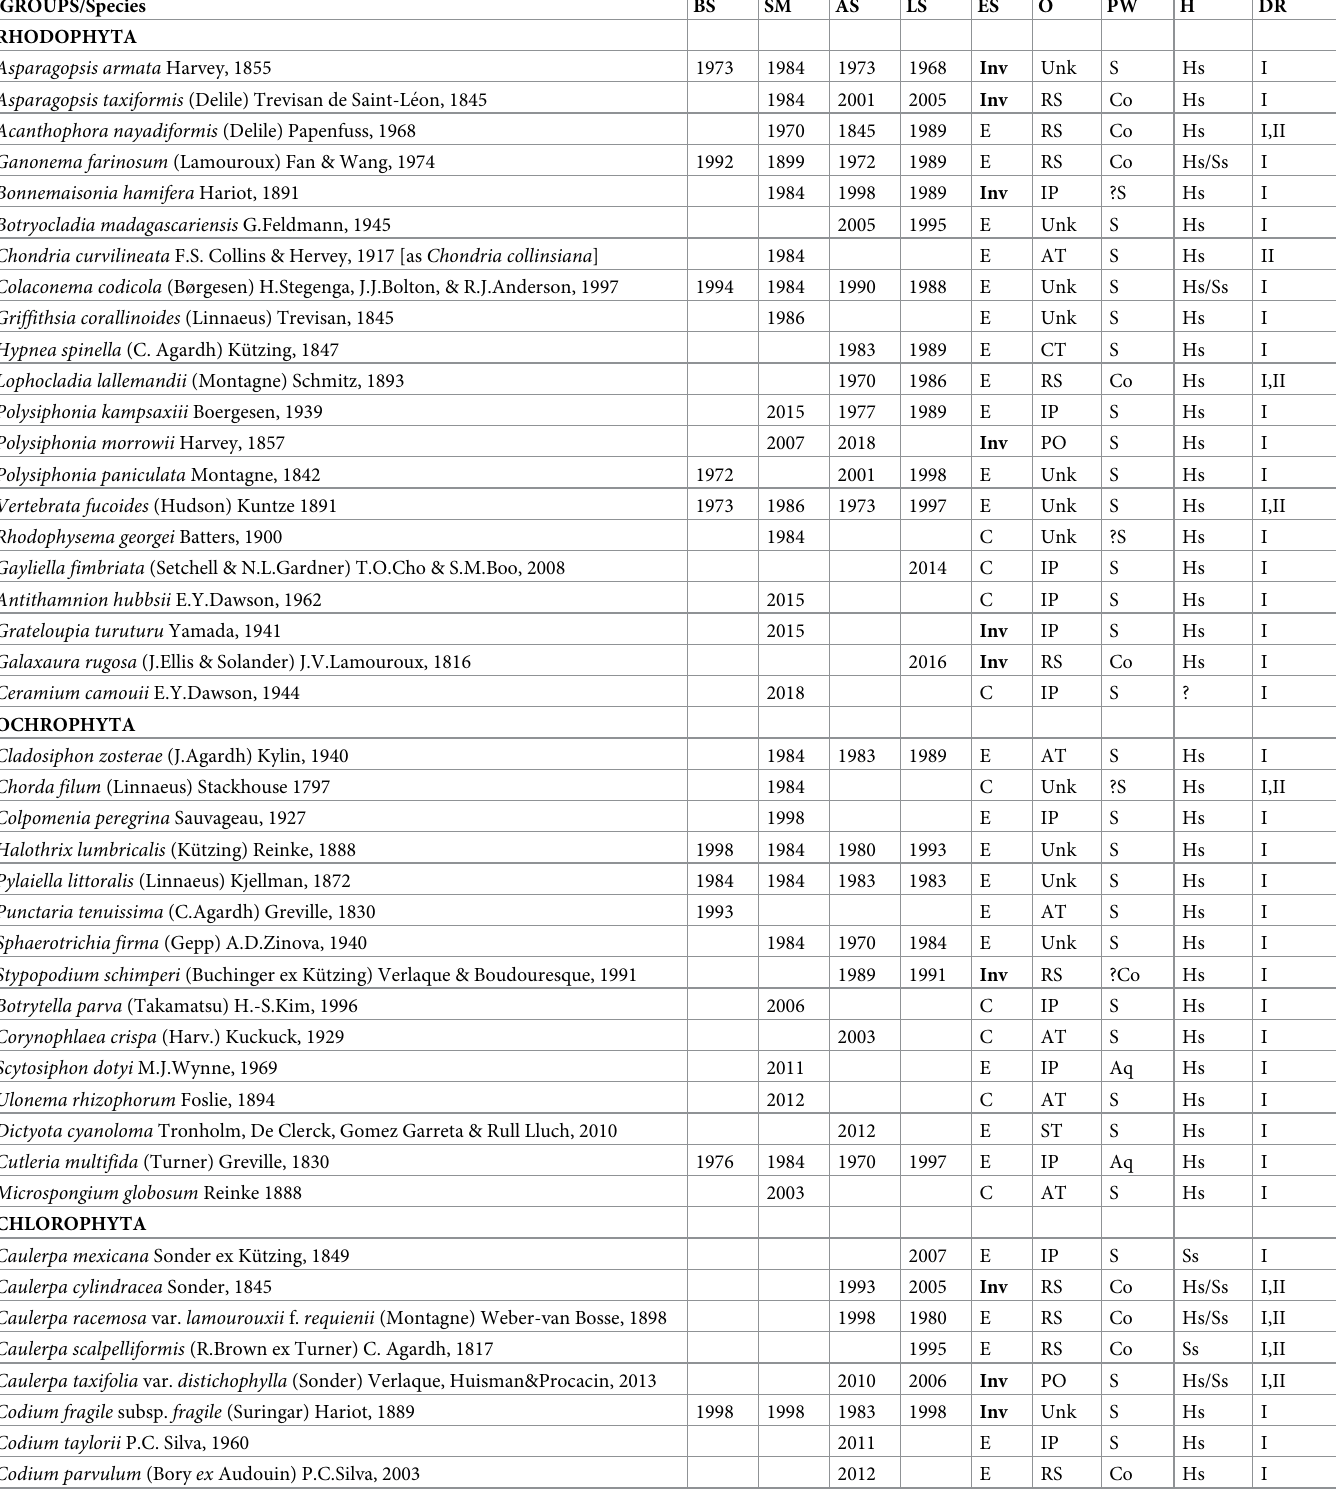
Table 1. The list of alien species and their first year of observations from the coasts of Turkey. GROUPS/Species BS SM AS LS ES O PW H